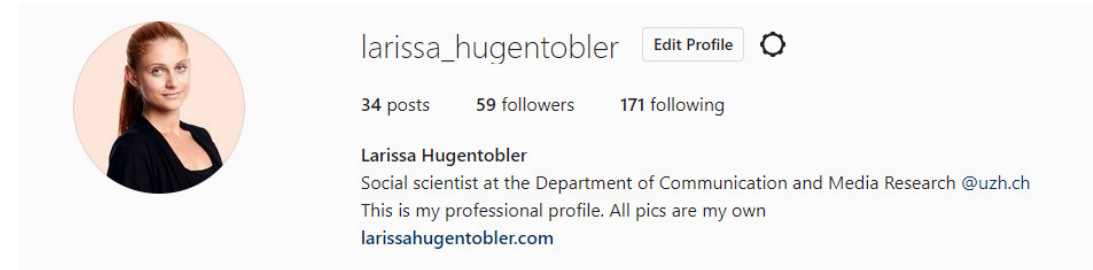
Figure 1. Researcher